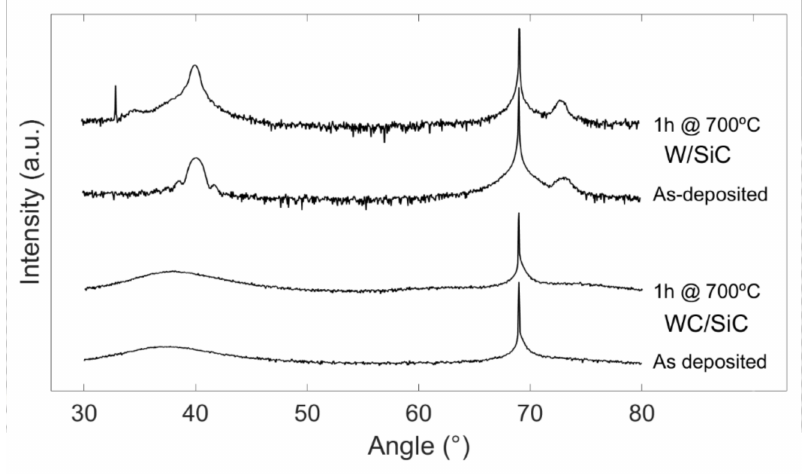
Figure 11. HAXRD spectra of as-deposited and annealed W/SiC (21.3 nm) and WC/SiC (28.5 nm) multilayers. The samples were annealed to 700 ◦ C for 1 h.